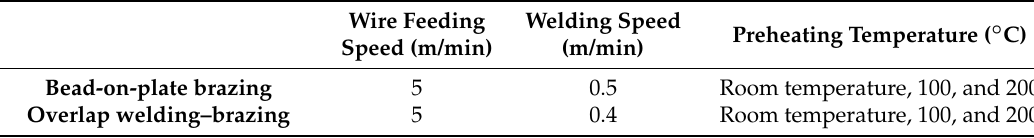
Table 2. Processing parameters of the bead-on-plate brazing and overlap welding–brazing.